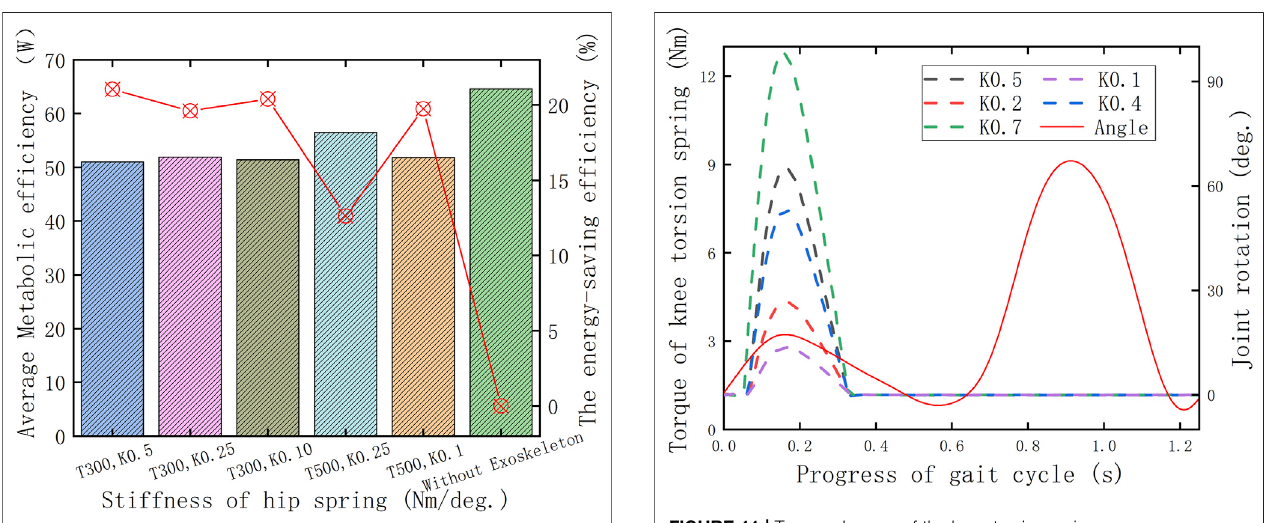
FIGURE 10 | Energy-saving ef fi ciency of the HESM fort the hip joint.